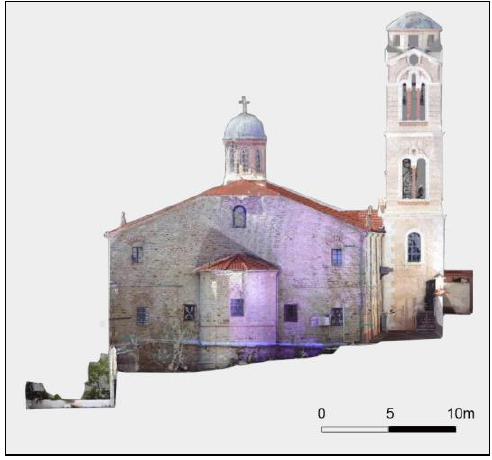
Figure 4 . A point cloud of the east façade of the Timios Prodromos church using the Faro Focus 3D.